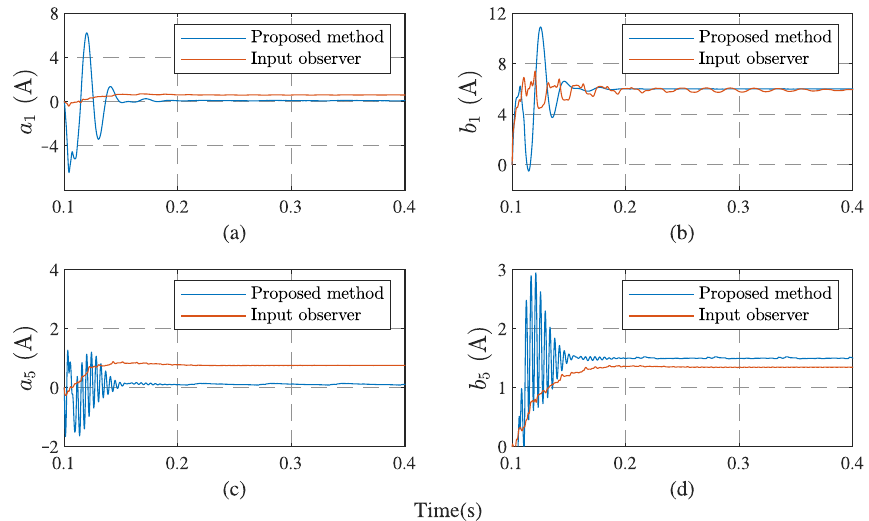
Figure 18. Comparison between proposed method and input observer: ( a ) a 1 . ( b ) b 1 . ( c ) a 5 . ( d ) b 5 .